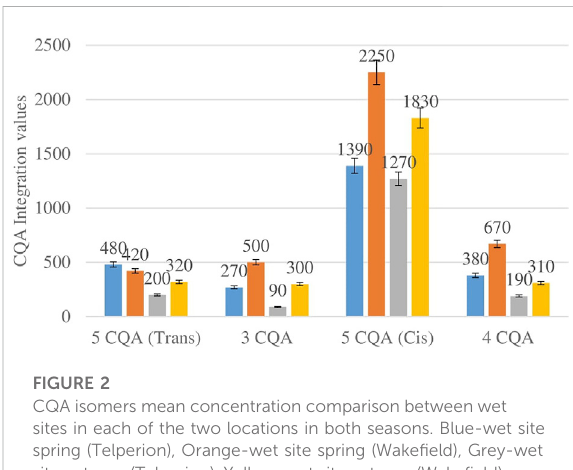
FIGURE 2 CQA isomers mean concentration comparison between wet sites in each of the two locations in both seasons. Blue-wet site spring (Telperion), Orange-wet site spring (Wake fi eld), Grey-wet site autumn (Telperion), Yellow-wet site autumn (Wake fi eld).